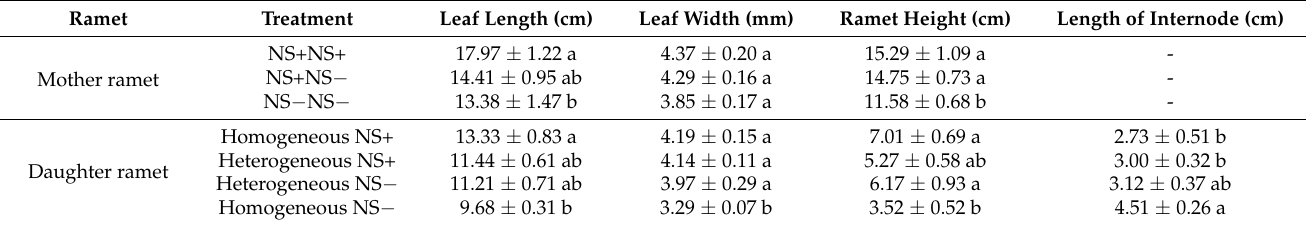
Table 2. Growth indices of Kentucky bluegrass under different water treatments.